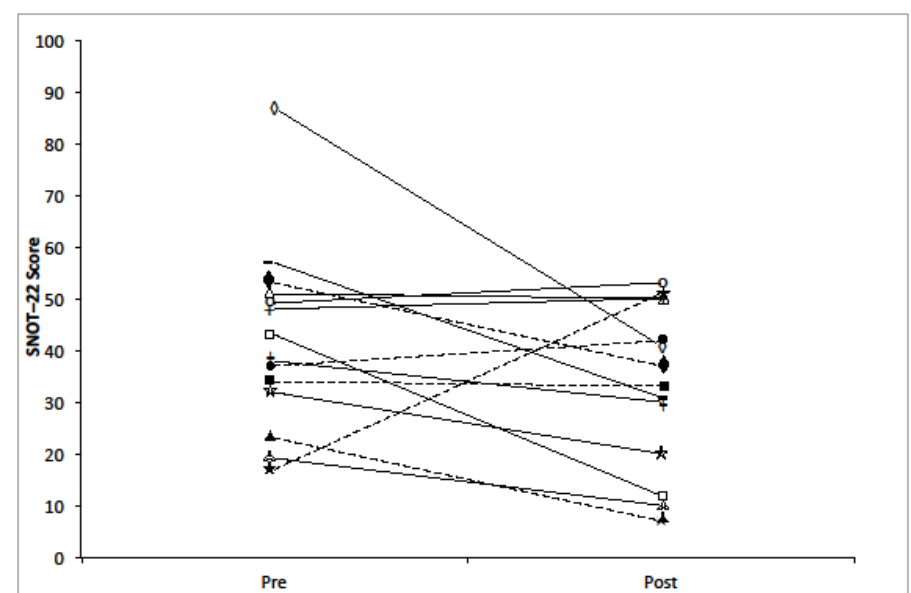
Figure 4. Change in SNOT-22 scores for all patients after six treatments. Patients with baseline facial pain are solid lines, and patients without baseline pain are dotted lines.